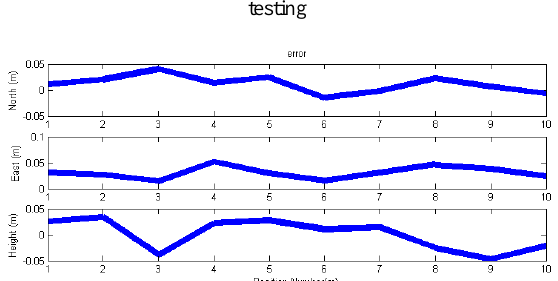
Figure 13 The position error of control point’s feedback